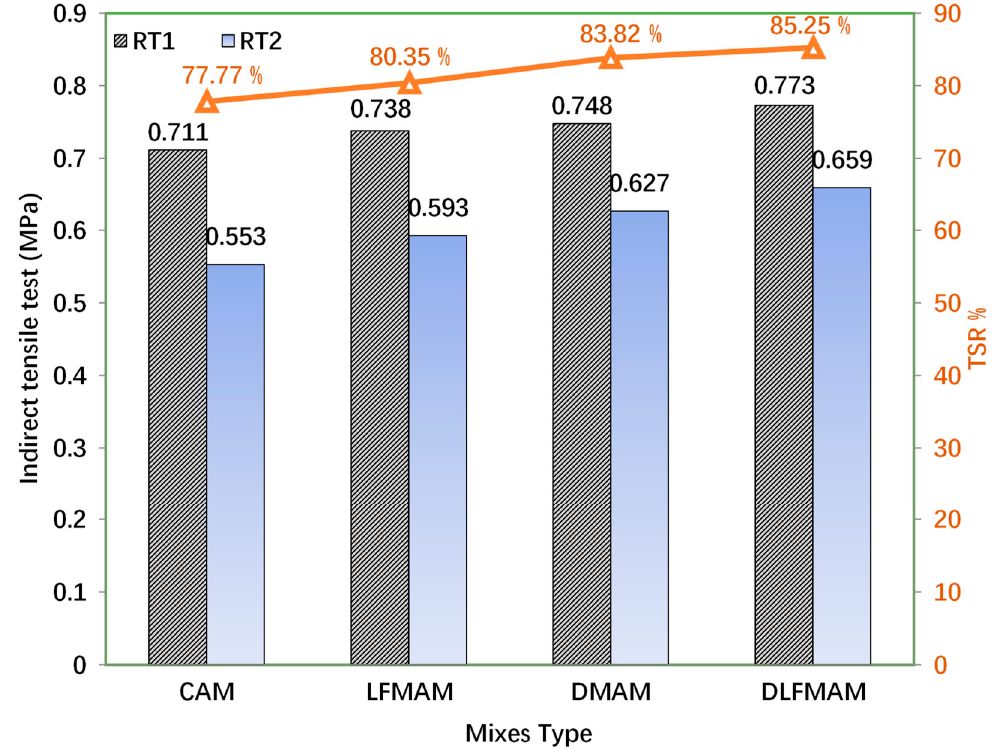
Figure 9. Results of the indirect tensile test.